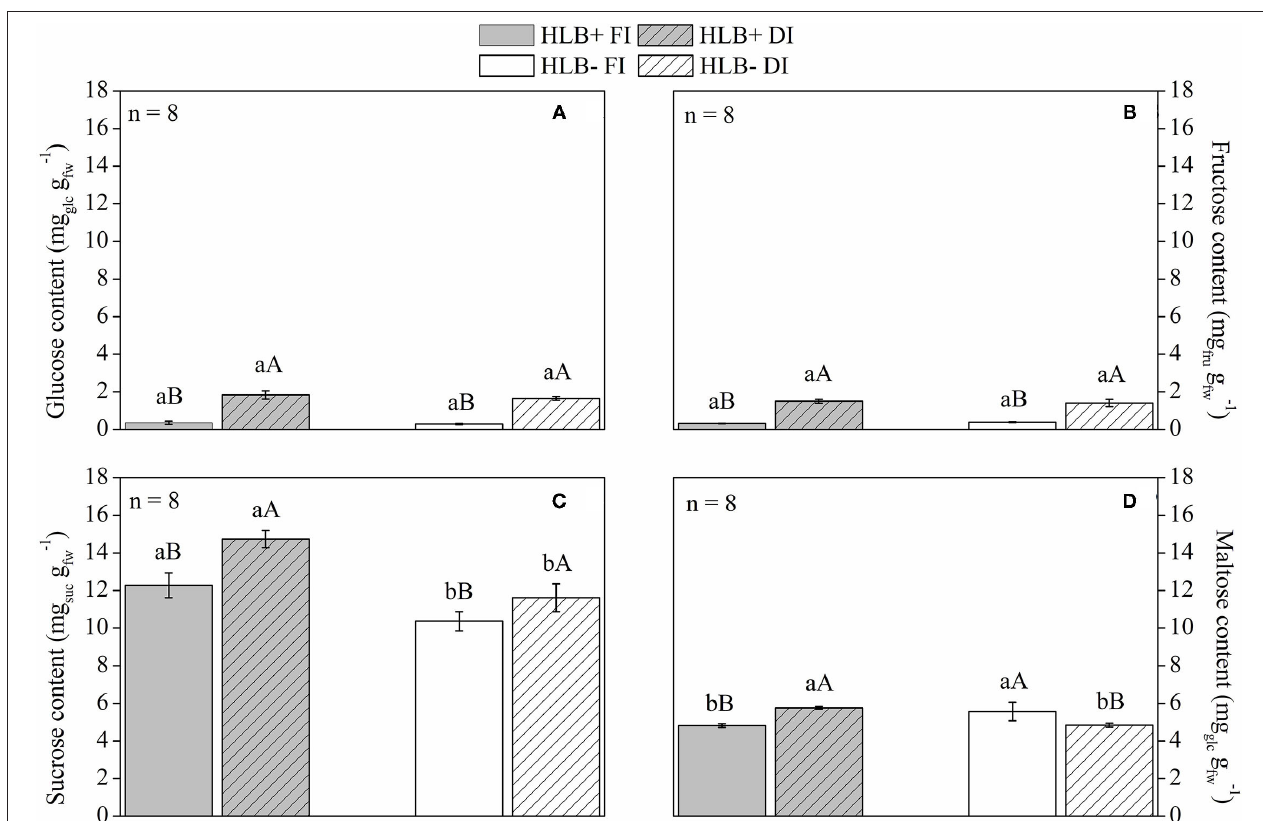
FIGURE 8 | (A) Glucose, (B) fructose, (C) sucrose, and (D) maltose (D) content of leaves on “Valência” orange trees [ Citrus sinensis (L.) Osbeck] grafted on citrumelo “Swingle” rootstock [ Citrus paradisi Macfad. x Poncirus trifoliata (L.) Raf.] either infected with “ Ca . Liberibacter asiaticus” ( + ) or healthy (–) and exposed to two water management treatments: fully irrigated (FI) and deficit-irrigated (DI). Values are mean ± SE. ( n = 8). Means followed by the same letter do not differ between water management treatments within the same HLB infection conditions (upper case) or between HLB infection conditions within the same water management treatment (lower case) according to unpaired Student’s t -test at 5%